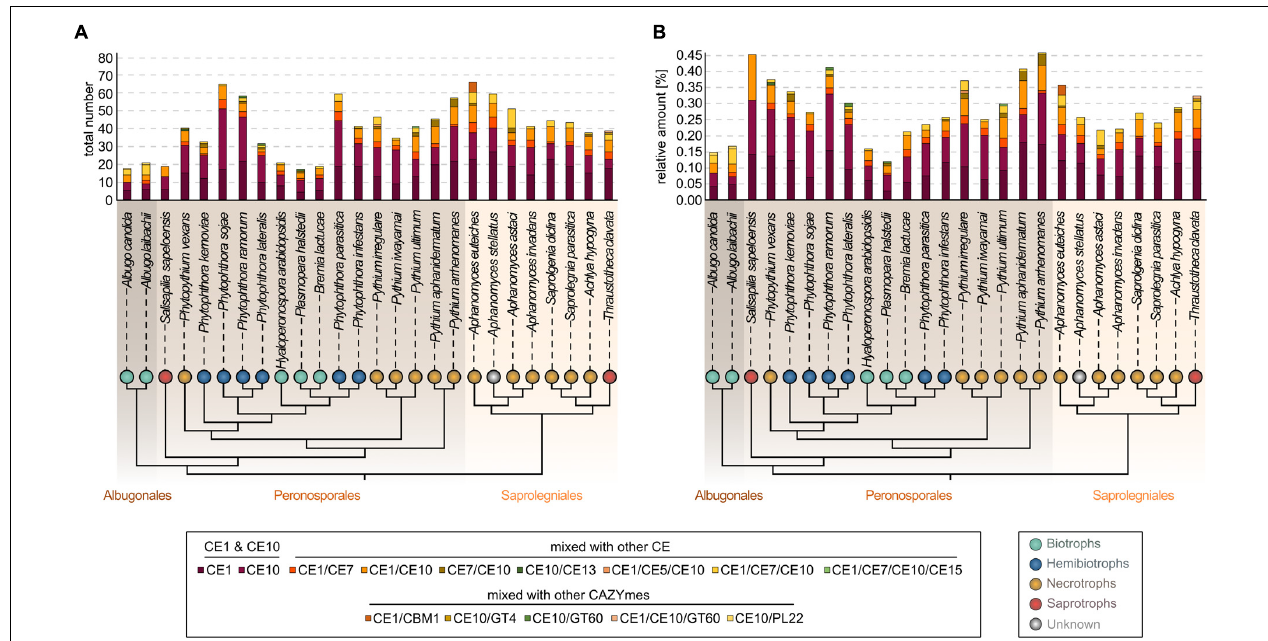
FIGURE 1 | Distribution of carbohydrate esterase 1 (CE1)- and 10 (CE10)-coding genes among diverse oomycete genomes. On the top, a stacked column chart shows the coding capacity for the CE1 and CE10 families and composite enzymes with CE1 and CE10 domains found in 25 oomycete genomes and the transcriptome of Salisapilia sapeloensis ; (A) the total number and (B) the relative coding capacity for CEs in relation to the total number of protein-coding genes on the genome—or in case of S. sapeloensis in relation to all the oomycete-specific protein-coding genes detected in the transcriptome. The stacked columns are projected onto a cladogram (drawn based on Diéguez-Uribeondo et al., 2009; Hulvey et al., 2010; McCarthy and Fitzpatrick, 2017; Fletcher et al., 2019) that shows the phylogenetic relationship between the oomycete species whose genomes/transcriptome were analyzed here. Note that alternatively, S. sapeloensis may also be placed between the genera Phytophthora and Pythium (Bennett and Thines, 2019). Background shading of the cladogram indicates the taxonomic orders (Albugonales, Peronosporales, and Saprolegniales). Colored bubbles indicate the lifestyles. Lifestyles were categorized according to Hughes and Grau (2007), Hulvey et al. (2010), Judelson (2012), Fawke et al. (2015), and Misner et al. (2015).